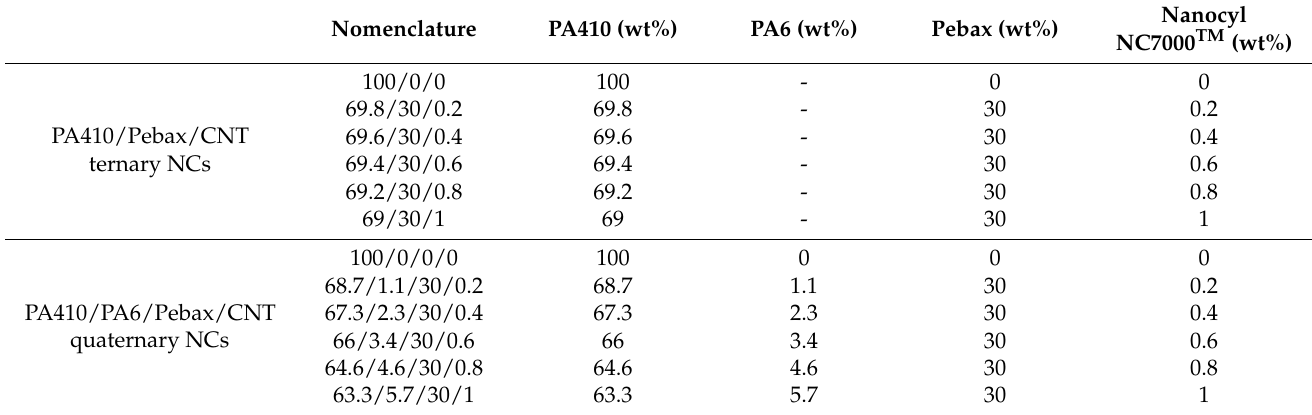
Table 1. PA410, PA6, Pebax, and CNT wt% contents in the compositions